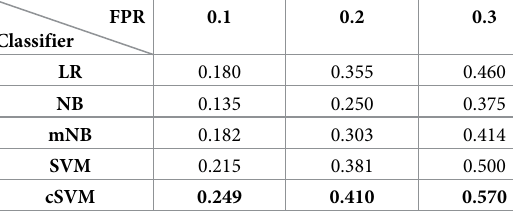
NB, and SVM) achieve better AUCs with GPLVM imputation than the LOCF and the mean imputation. This reveals that the GPLVM-based imputation outperforms the traditional